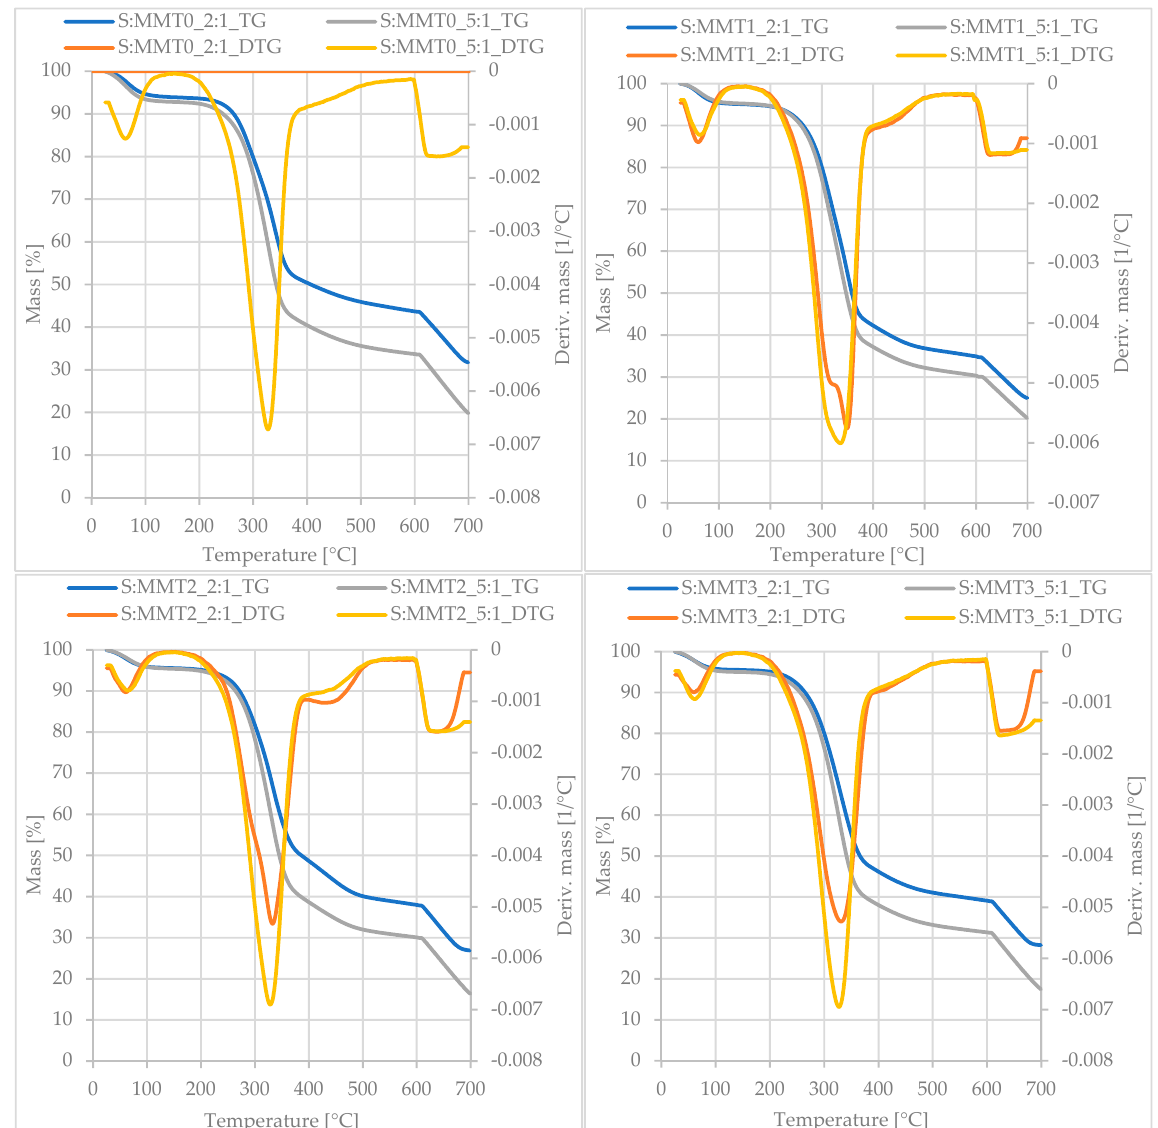
Figure 2. The thermogravimetric (TG) curves and the derivative of the TG versus time (DTG) curve of straw-montmorillonite fillers.